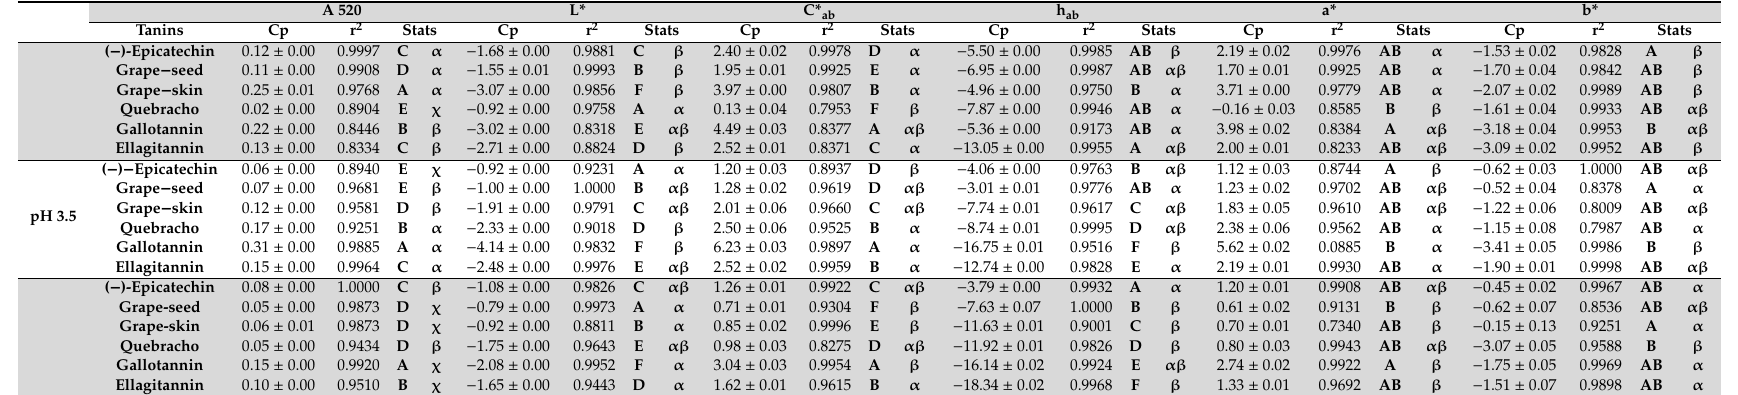
Table 2. Copigmentation e ff ectiveness (Cp) of model wine solutions of malvidin-3- O -glucoside (50 mg / L) at di ff erent pH levels, supplemented with increasing concentration of ( − )-epicatechin and oenological tannins after one week of experimentation.